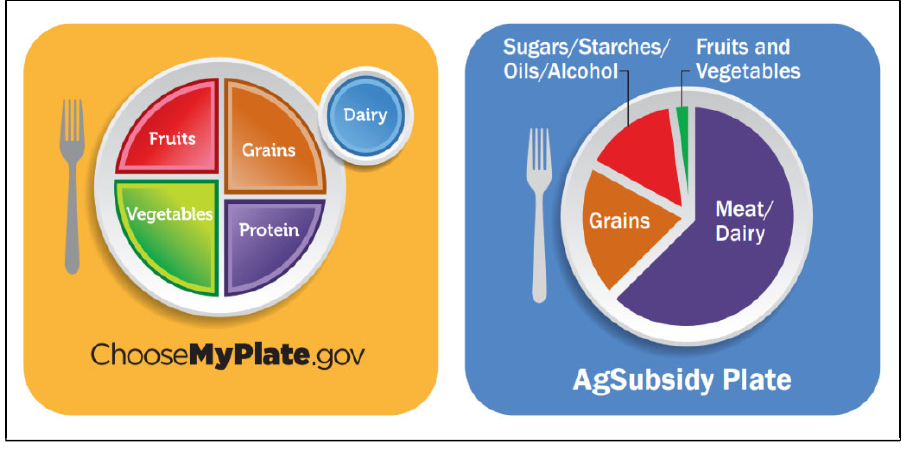
Figure 2. Comparison of MyPlate versus AgSubsidy